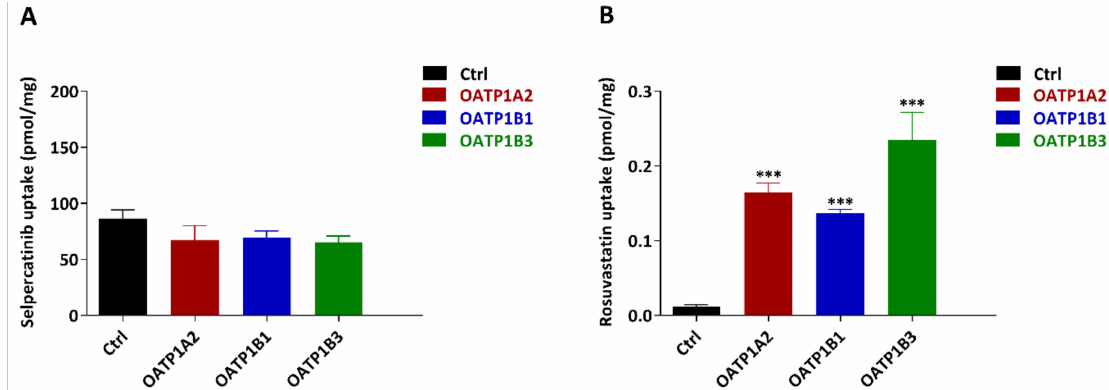
Figure 4. In vitro uptake of selpercatinib ( A ) and positive control rosuvastatin ( B ) by human OATP1A2, OATP1B1 and OATP1B3. Uptake of 5 µ M selpercatinib and 0.2 µ M rosuvastatin were measured after 2.5 min incubation using vector- transfected (control) or OATP1A2-, OATP1B1- or OATP1B3- overexpressing HEK293 cells. n = 3, data are given as mean ± S.D. *, p < 0.05; **, p < 0.01; ***, p < 0.001 compared to control